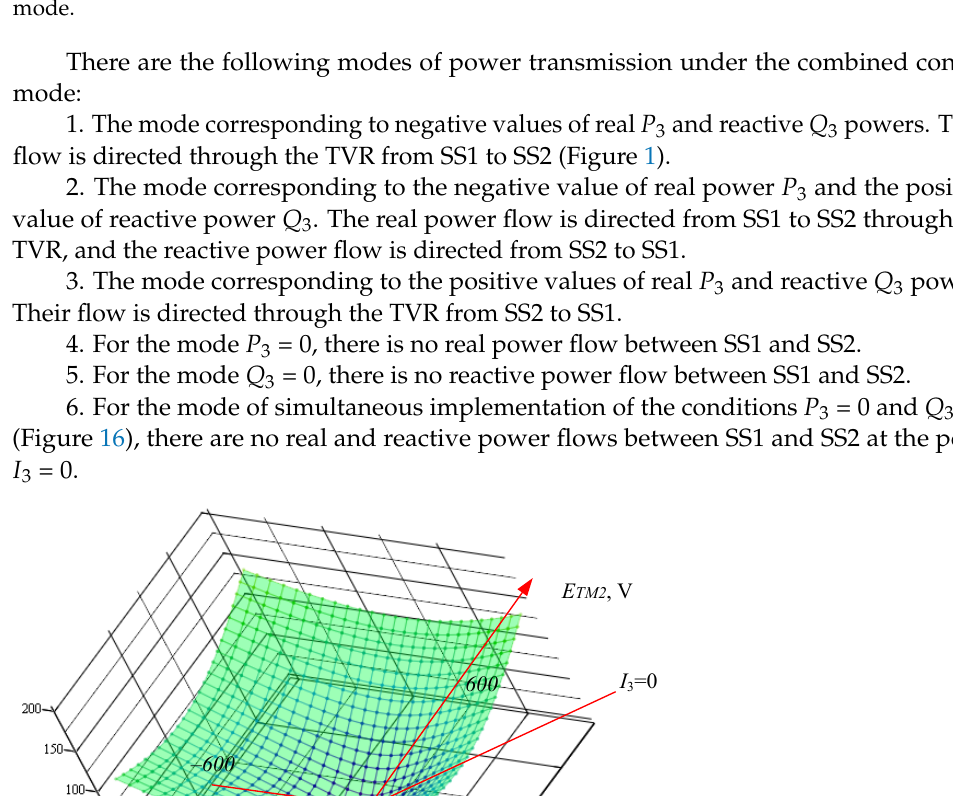
Figure 15. Real and reactive power flows between SS1 and SS2 under voltage magnitude control mode.